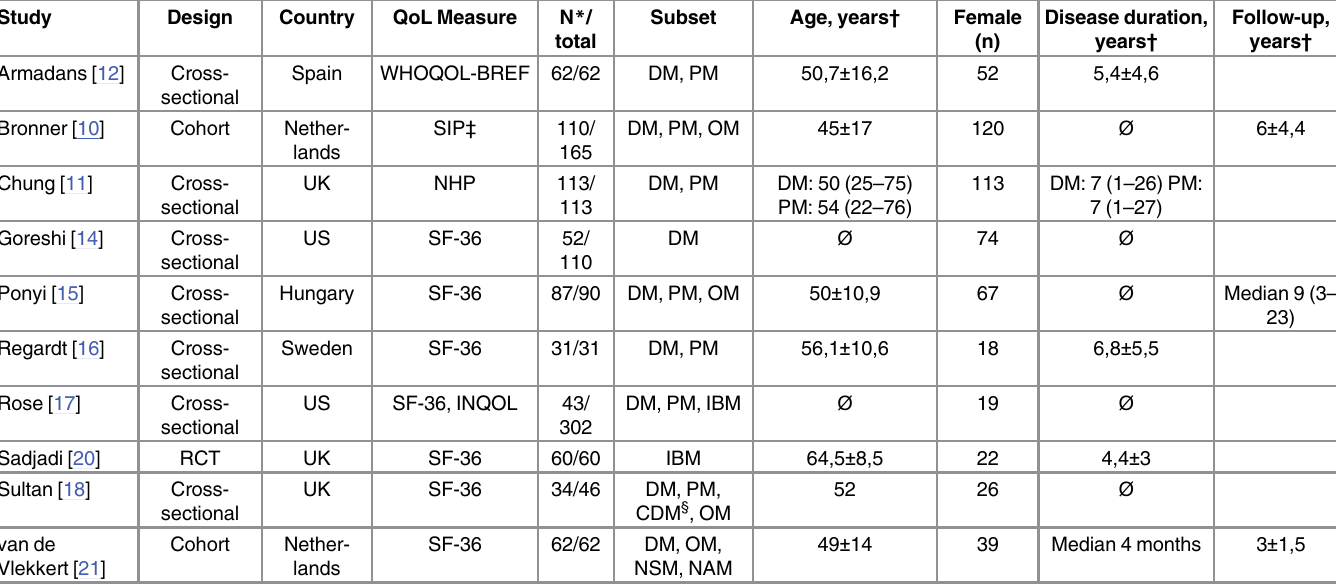
Table 1. Description of the studies included in this review.